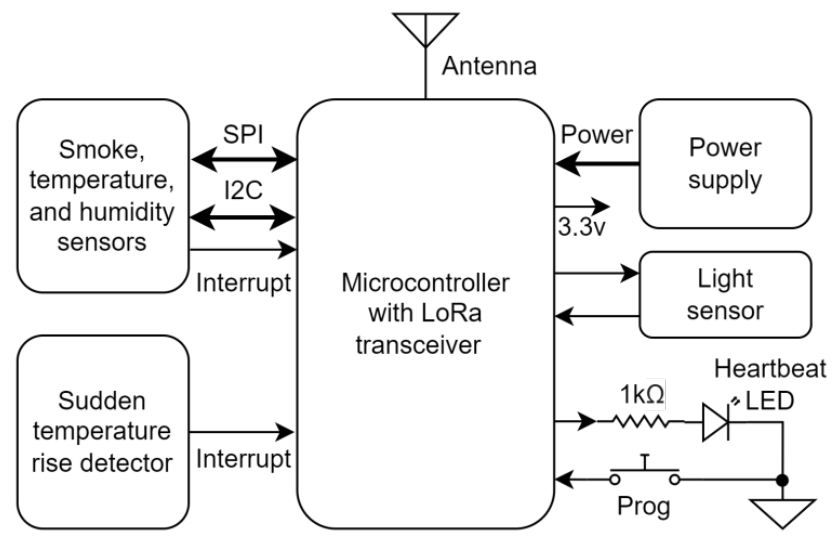
Figure 2. Block diagram of the sensor node hardware.